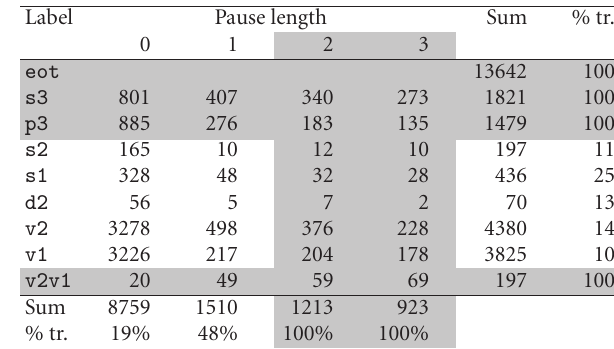
Table 3: Frequencies of syntactic and pause labels in the full database (48401 words), grey rows and columns indicate chunk triggering boundaries; “% tr.” displays the percentage of triggering boundaries within the specific